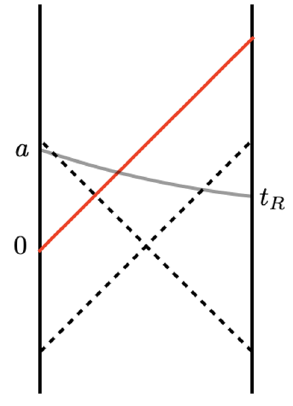
Figure 6 . Illustration of the geodesics anchored at a late time t L = a on the left, thus serving as a probe of the